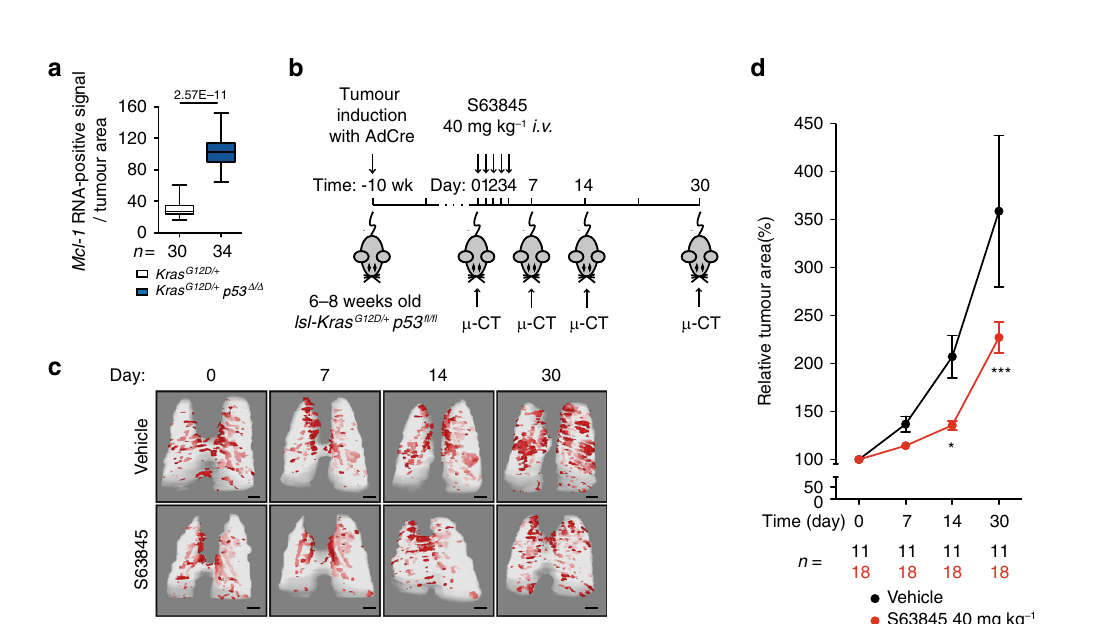
Fig. 5 Pro-survival Mcl-1 is critical for LUAD development. a Experimental design. b , c Representative images ( b ) and quanti fi cation ( c ) of Mcl-1 mRNA in situ hybridisation in lesions and adjacent healthy tissue. Inserts are higher magni fi cation of corresponding images. n = number of lesions. Data were analysed by one-way ANOVA ( p = 6.600E − 9, F (2,39) = 31.73, p values from post-hoc analysis with Bonferroni correction are reported in fi gure. d Representative H&E staining of lung tissue sections at 19 weeks after AdCre virus infection. Inserts are higher magni fi cation of indicated areas. Scale bar represents 2 mm, 1 mm, 100 µ m, or 10 µ m. e Number of lesions per section. n = number of sections. Three sections per animal, separated by 100 µ m, were assessed. Data were analysed by Kruskall – Wallis test ( p = 5.544E – 6, p values from post-hoc analysis with Dunn ’ s correction are reported in fi gure). f Representative renderings of the µ -CT analysis. g Quanti fi cation of tumour volume expressed as percentage of the lung volume. n = number of mice. Data were analysed by one-way ANOVA ( p = 0.0145, F (2,10) = 6.656, p values from post-hoc analysis with Bonferroni correction are reported in fi gure). Data in panel ( c , e , and g ) are representative of four independent experiments and are presented as dot plot and show mean ± SEM. h Representative images of pulmospheres generated from dissected tumour tissue (2 lesions from 2 mice/genotype). Inserts showing individual pulmospheres. Scale bar is 25 µ m or 100 µ m. i Quanti fi cation of pulmosphere area ( µ m 2 ) over the cultivation period. n = number of pulmospheres. Data are presented as mean ± SEM and were analysed by repeated measure two-way ANOVA (for time, genotype, and interaction effects, p < 0.0001). p values from post-hoc analysis with Bonferroni correction are reported in the panel (** p < 0.01 and *** p < 0.001).